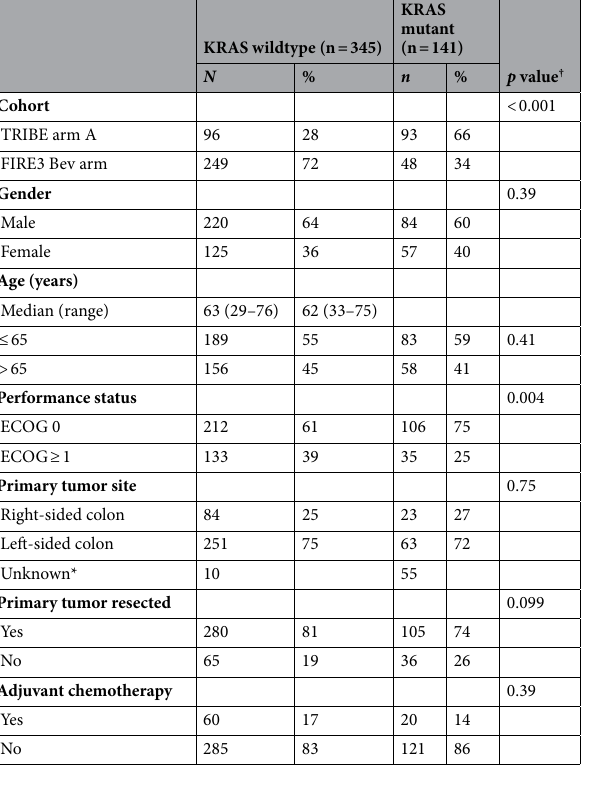
Table 1. Baseline comparisons between KRAS wildtype and KRAS mutant patients. † p value was based on Chi-square test. *Unknown group was not included in the